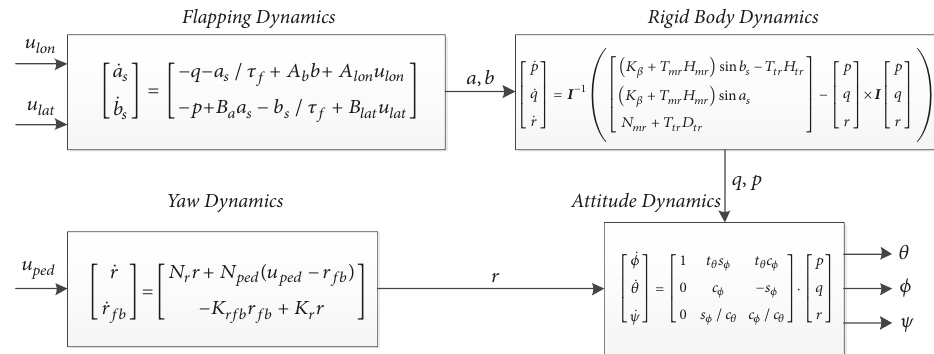
Figure 4: Interconnection of the helicopter dynamics model. The terms associated with the gravity force are disregarded.